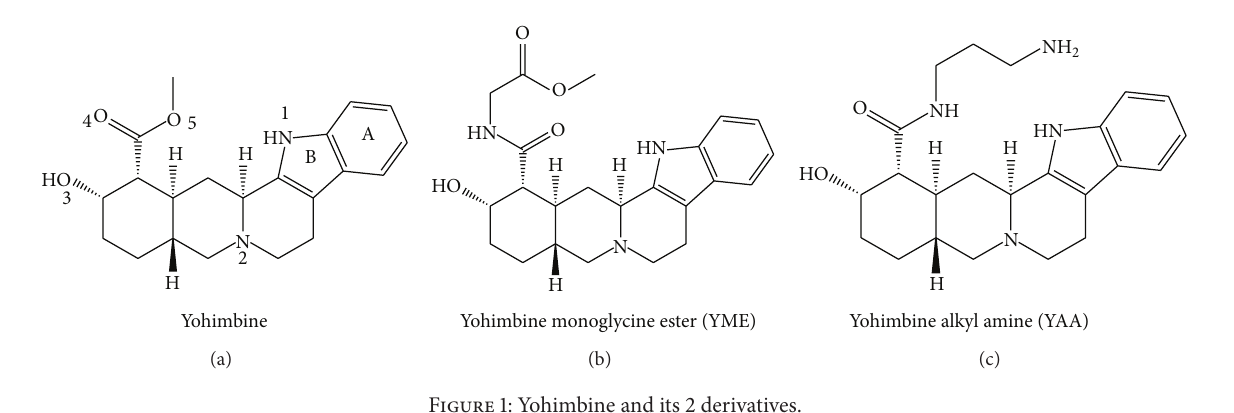
Figure 1: Yohimbine and its 2